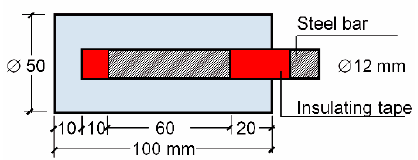
Figure 3. Longitudinal cross-section of the specimen.